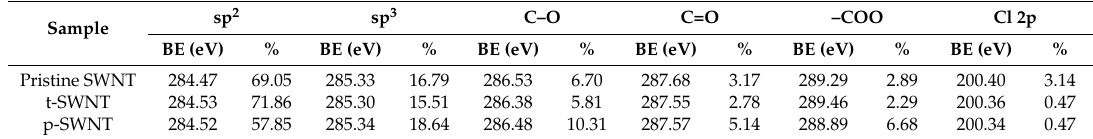
Table 1. XPS results of the modified SWNTs.